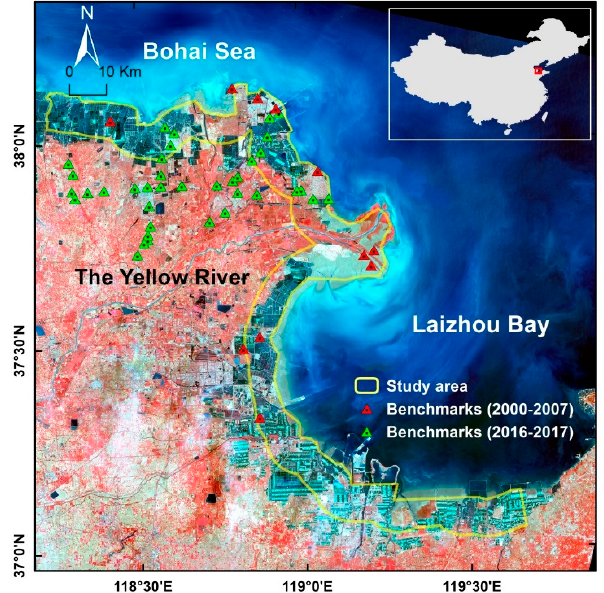
Figure 1. The location of the study area is outlined by the yellow polygon within the standard false-color Landsat 8 OLI image of the Yellow River Delta in September 2017. false-color Landsat 8 OLI image of the Yellow River Delta in September